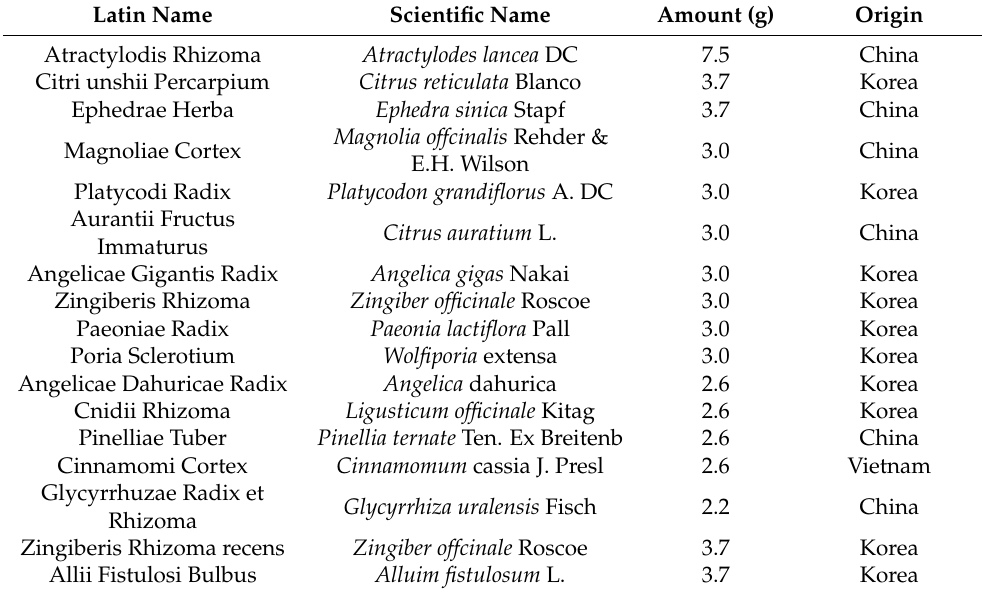
Table 2. Decoction of Ojeoksan